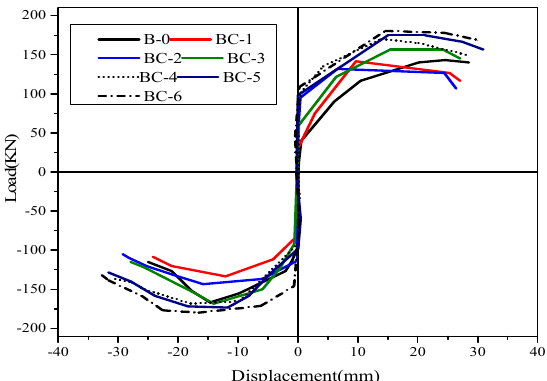
Figure 9. Strength envelopes for unstrengthened and strengthened beams.